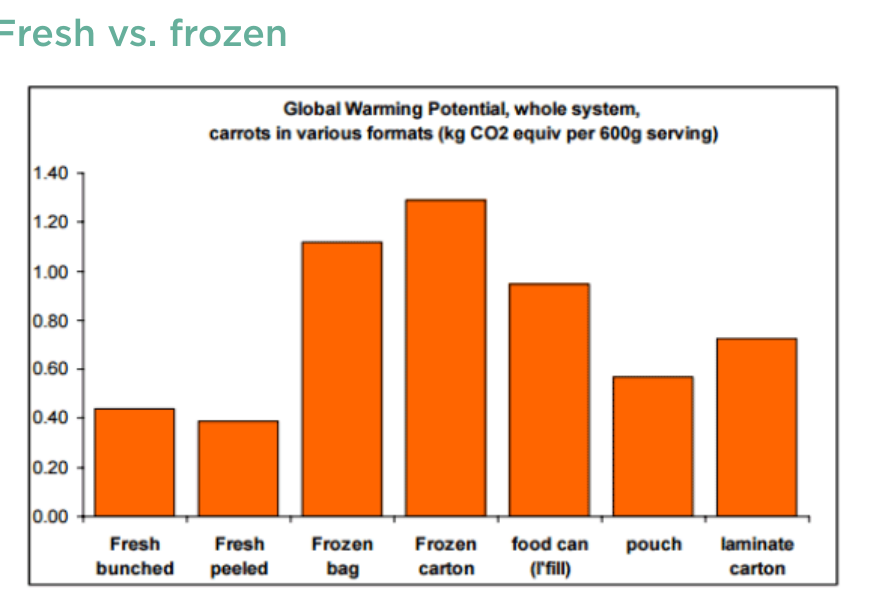
Figure 19: Greenhouse gas emissions for carrots according to type of preservation and packaging